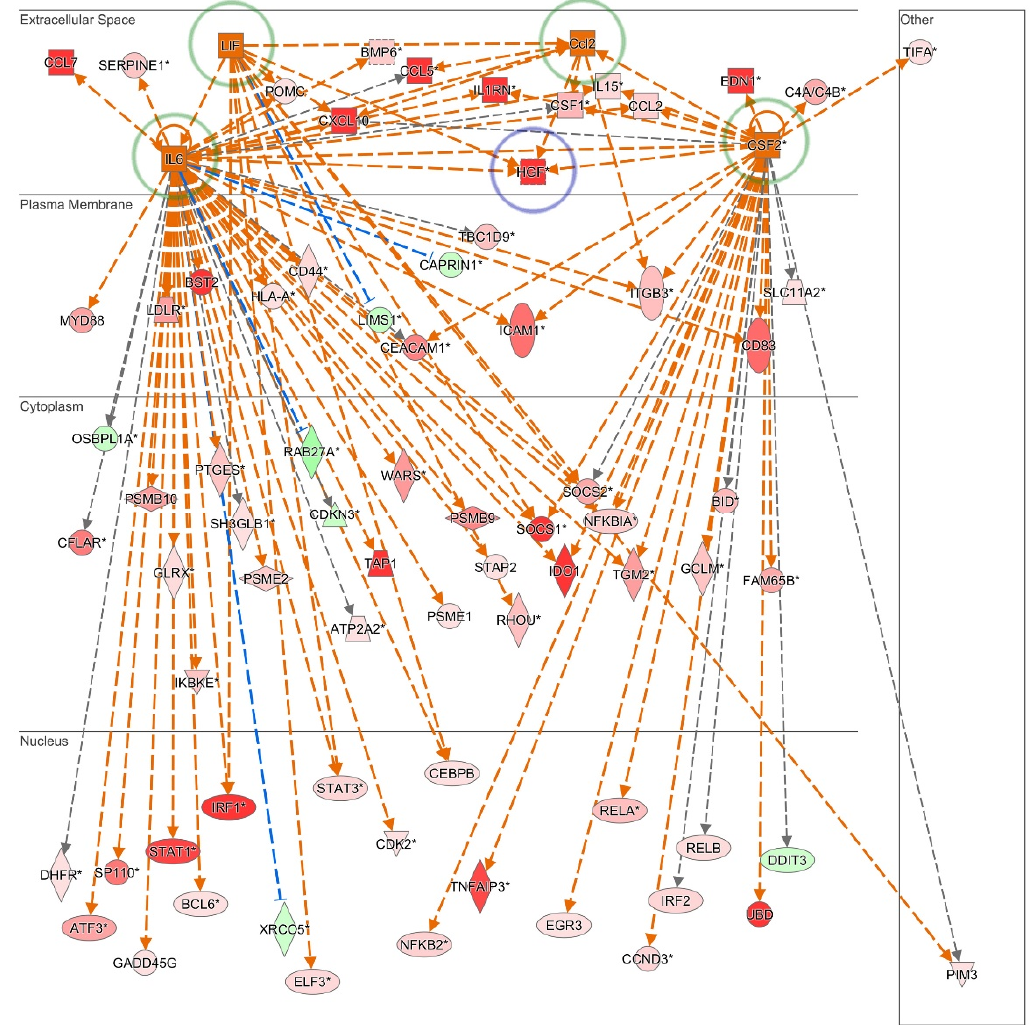
Figure 3. Upstream regulator interaction mapping. Mechanistic network of the upstream regulators CCL2 , CSF2 , IL6 and LIF (green circle) that are predicted to be activated in SKP in a pro-inflammatory environment. Their combined activation is predicted to significantly contribute to the strong increase in HGF (blue circle) secretion by SKP in the presence of inflammation. Legend: red represents increased and green decreased gene expression upon pro-inflammatory stimulation. Figure produced using Ingenuity Pathway Analysis Software.